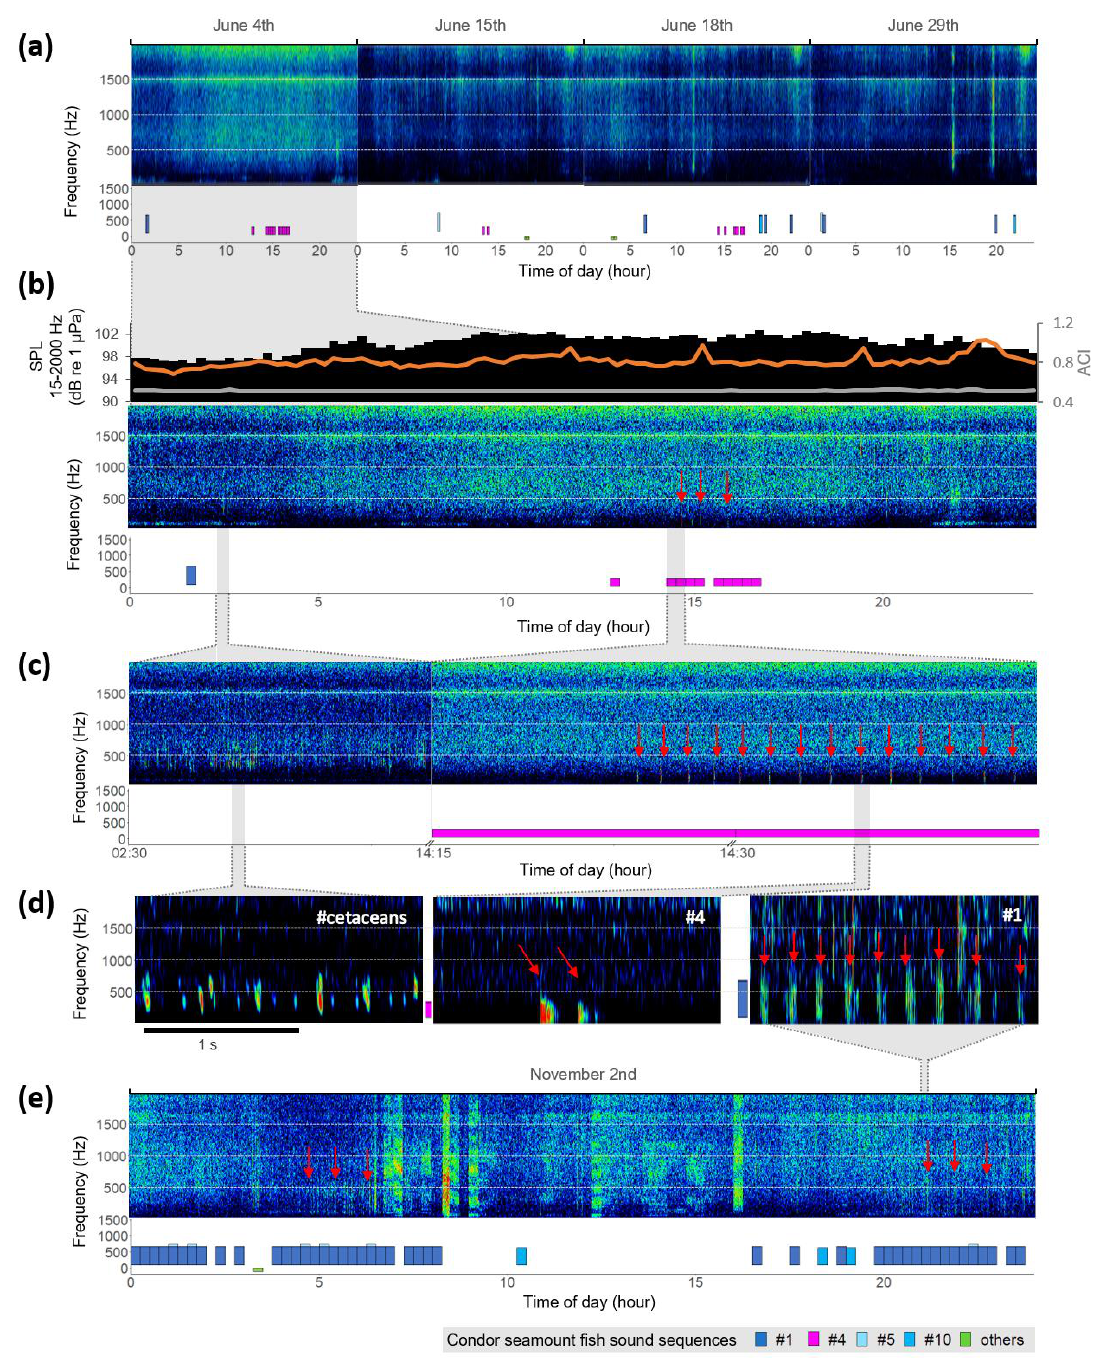
Figure 4. ( a ) Four-day long-term spectrogram from the Condor seamount (190 m deep) with segments expanded to 24 h ( b ), 270 s ( c ) and 2 s ( d ). Note that the 2 s spectrograms ( d ) depict fish sound sequence types (#1 and #4 reported in [23]) and some cetacean sounds. Sound acquisition was made 90 s every 900 s. Under each spectrogram the frequency range occupied by the most common fish sound sequences are represented. In ( b ), the SPL is presented for a 24 h period (June 4th - black bars) for the frequency band 15–2000 Hz, the average SPL considering the 4 days is depicted by the orange line, and the mean ACI is also presented for the same frequency band by the grey line. The bottom panel ( e ) represent a day in November 2008 with a higher occurrence of sounds. Spectrogram settings: Sampling frequency: 8 kHz; FFT size: 512; window size: 512; window type: Hamming, 50% overlap; for the extensions to observe individual sounds a FFT size of 512 and a window size of 64 were used. Arrows indicates fish sound sequences ( b , c , d , e ).